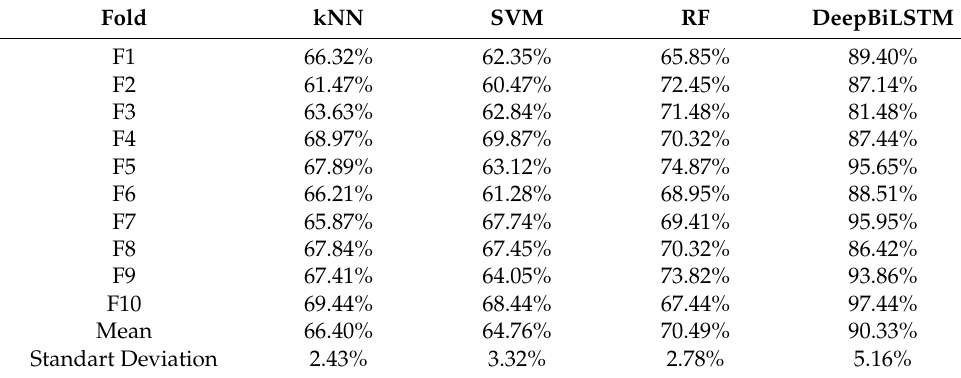
Table 3. Accuracy, mean and standard deviation results of arousal-valence